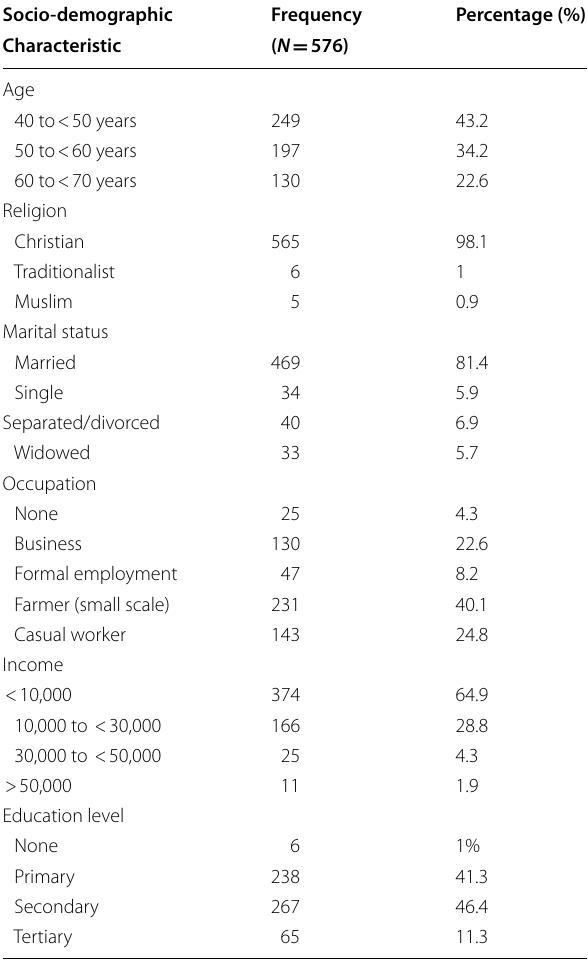
Table 1 Socio-demographic characteristics of